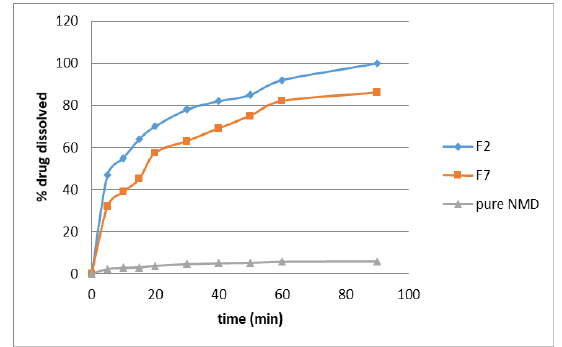
Figure 6. The dissolution profile of the prepared NMD NPs and pure NMD in SSF containing 0.5 % Brij-35.